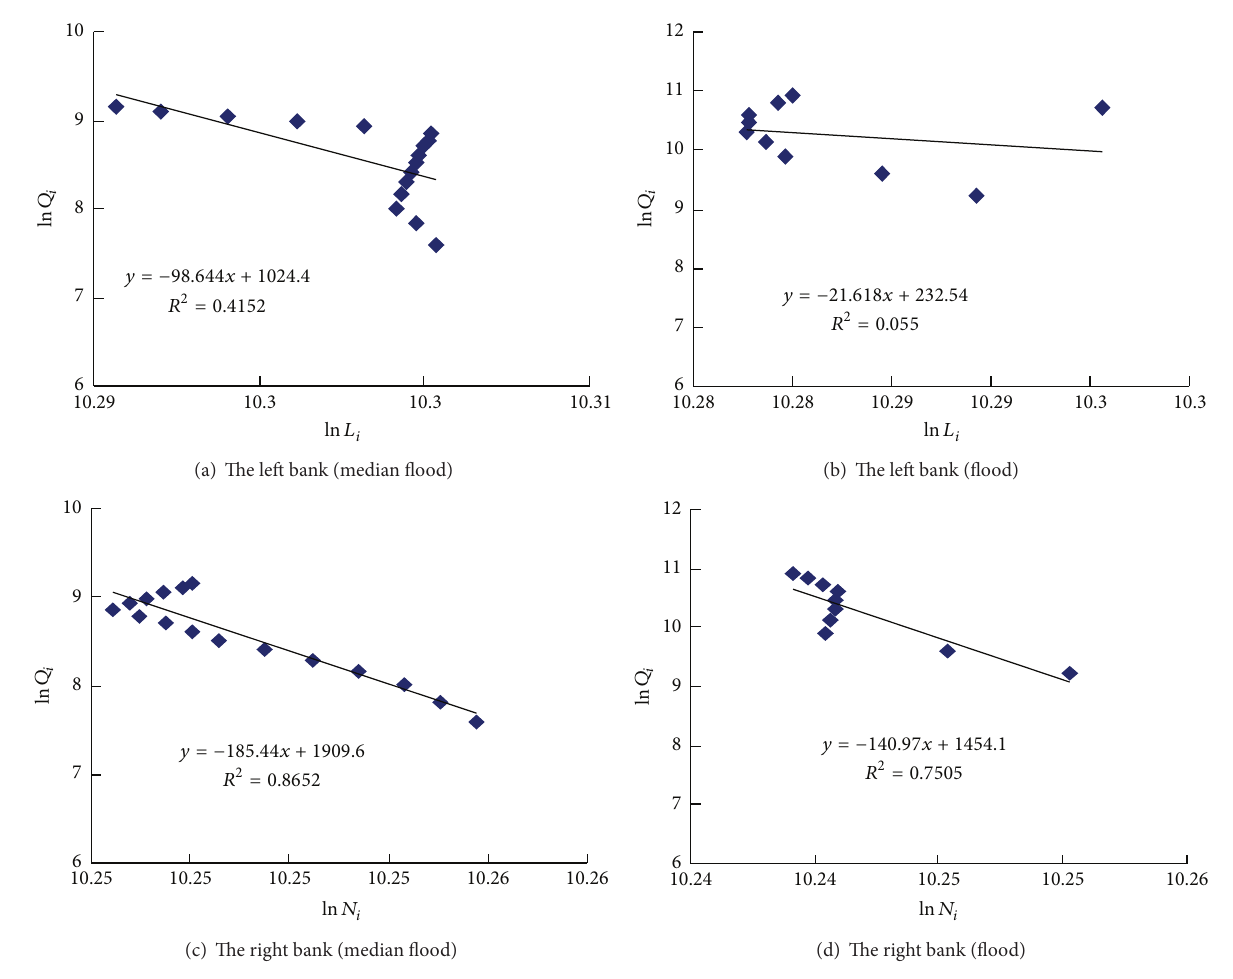
Figure 3: The original subdimensional fractal sequence of Chongqing city of Yangtze River.